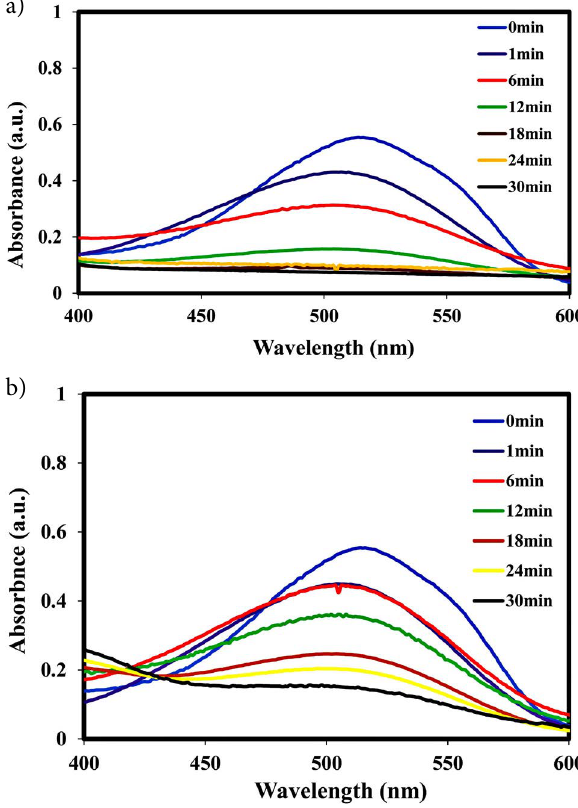
Fig 8. Time-dependent UV-vis absorption spectra for the reduction of Rh6G with NaBH 4 (a) in the presence and (b) absence of Ag/ HNTs at room